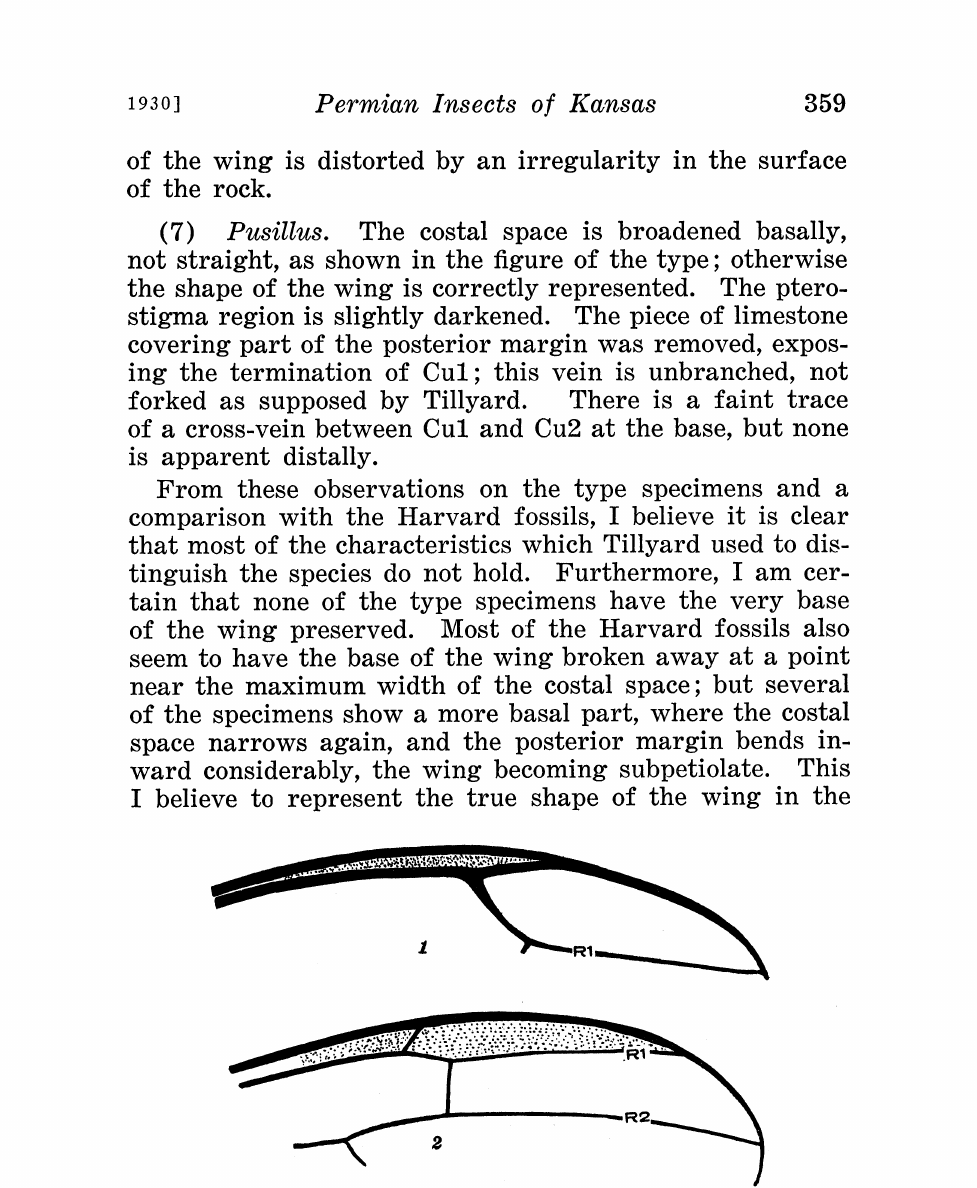
FIG. 2. Pterostigma of Doter minor Sell., with cross-vein; specimen :No. 3101, Mus. Conp.